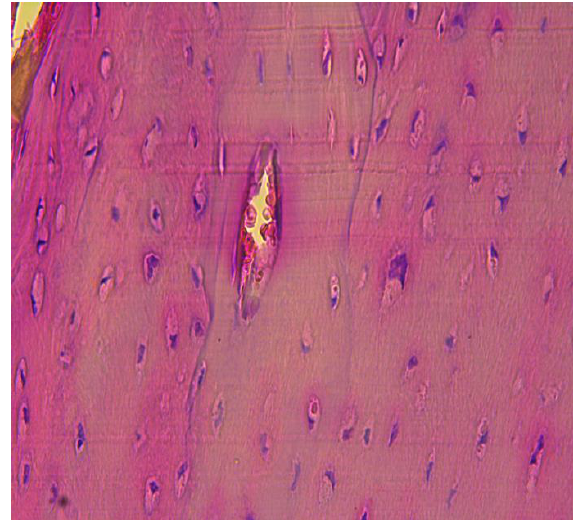
Figure (10): The osteocytes in group3.